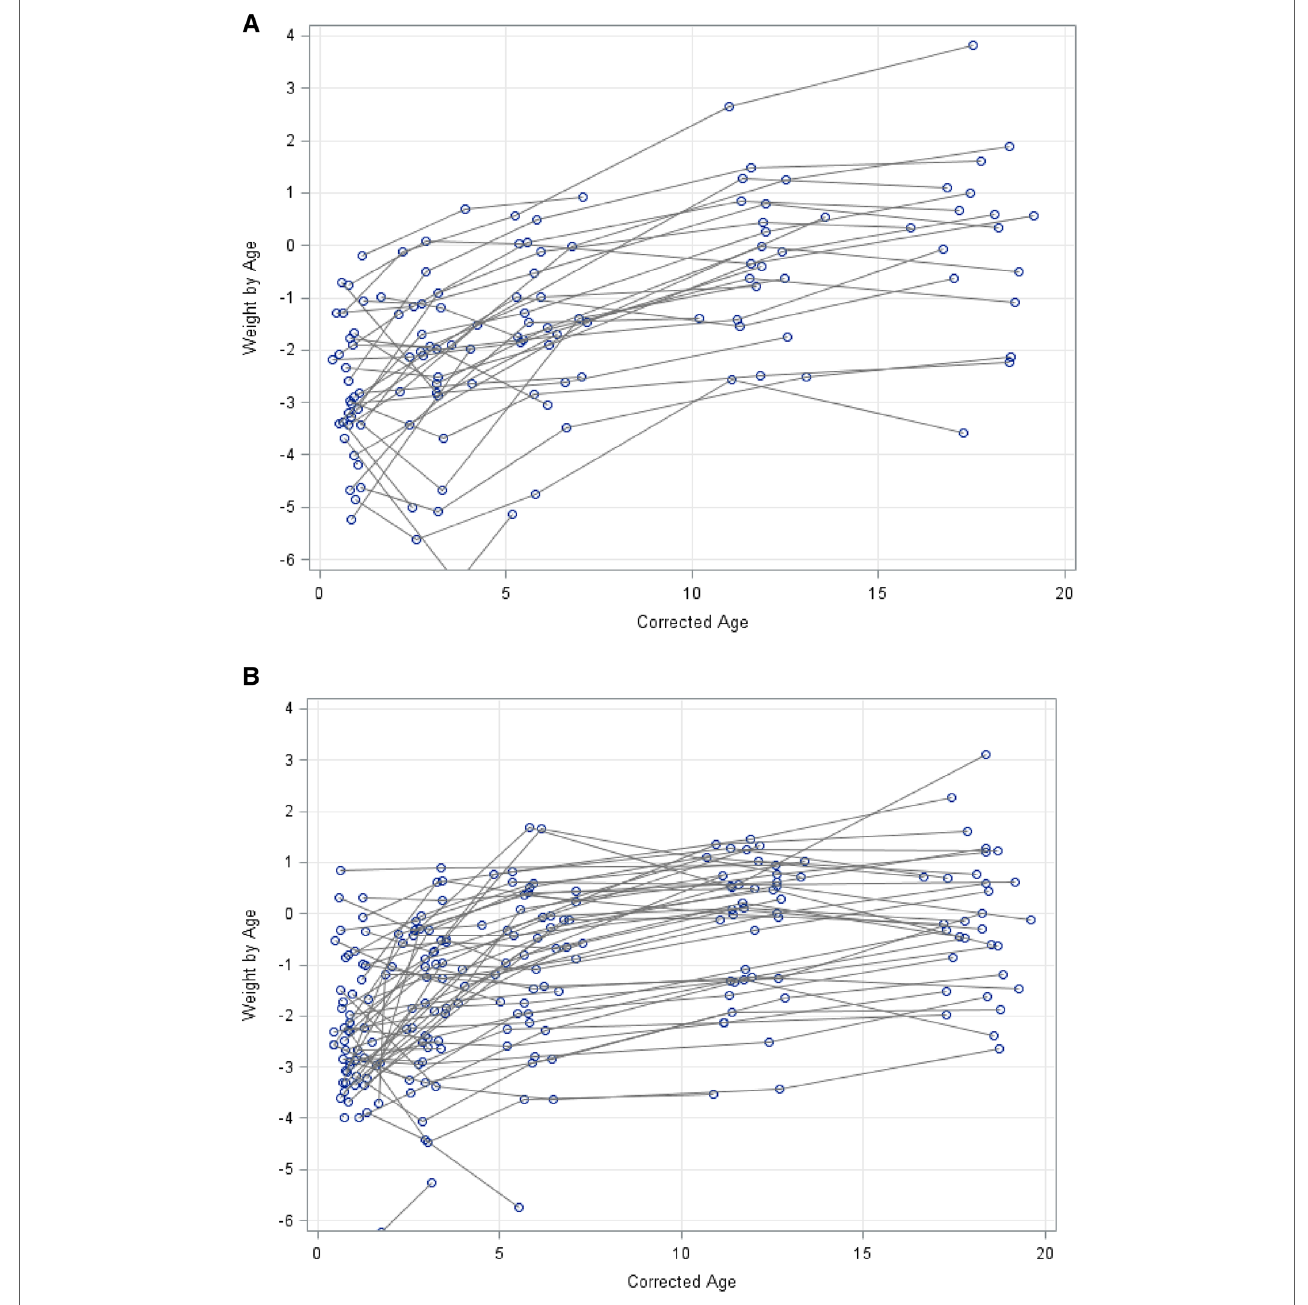
FIGURE 2 ( A ) growth weight-for-age z-scores in kg (WAZ) for males from 1 to 18 months. ( B ) growth weight-for-age Z-scores (WAZ) in kg for Females from 1 to 18